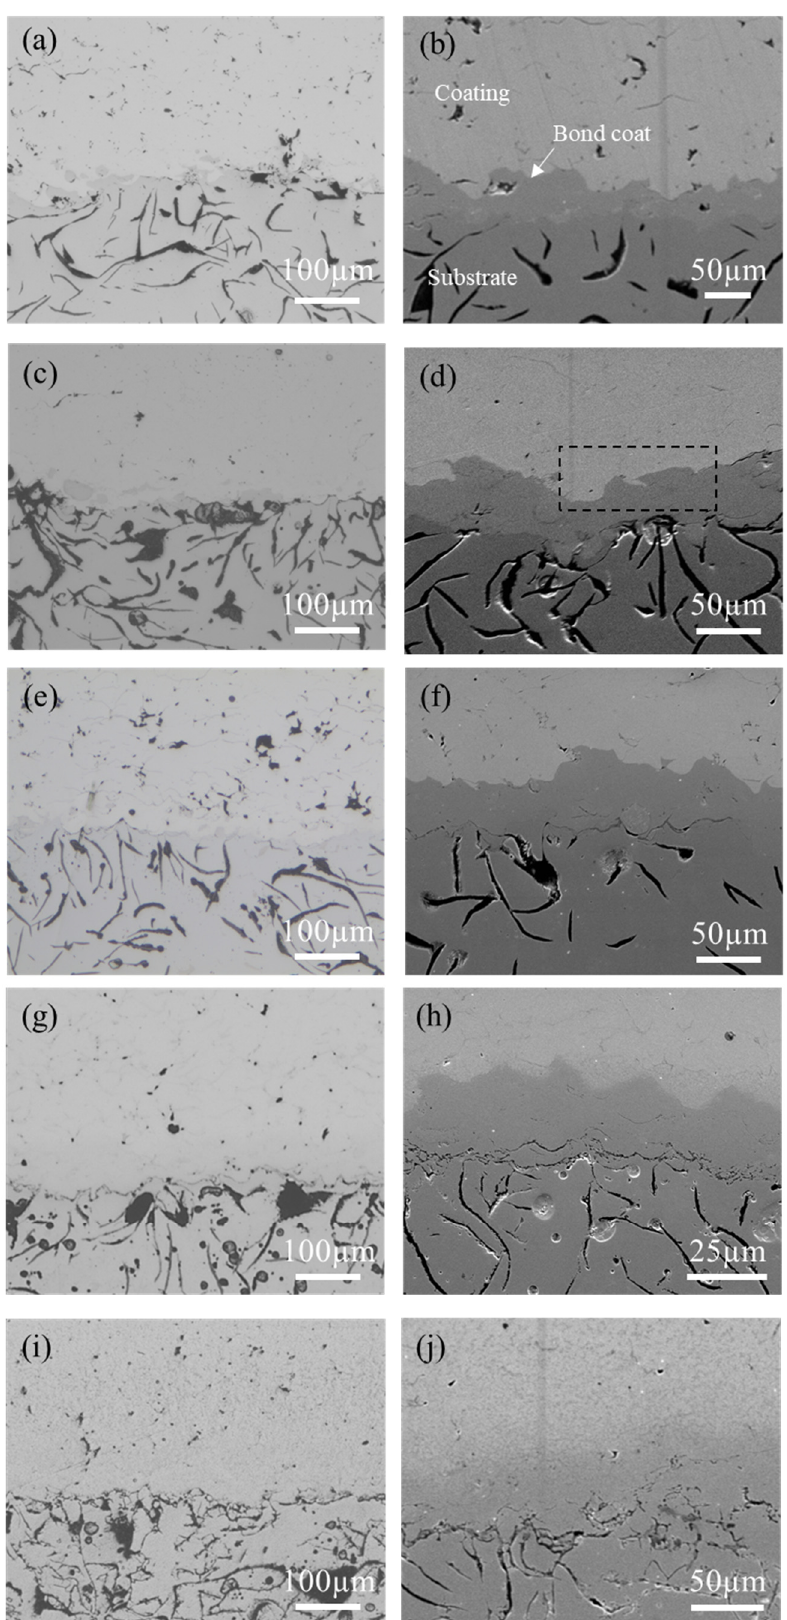
Figure 3. Optical ( a , c , e , g , i ) and SEM ( b , d , f , h , j ) micrographs of cold-sprayed IN625 coating on grey cast iron (GJL250) substrate at the interface for ( a , b ) as-sprayed, ( c , d ) 400-3, ( e , f ), 600-3, ( g , h ) 850-3 and ( i , j ) 1050-3. The description of the layers is shown in ( b ).